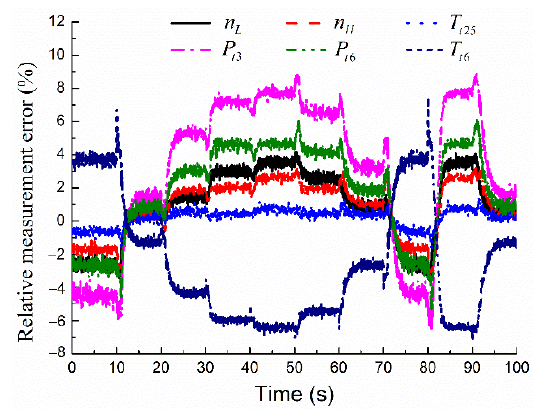
Figure 17. Unadapted measurement